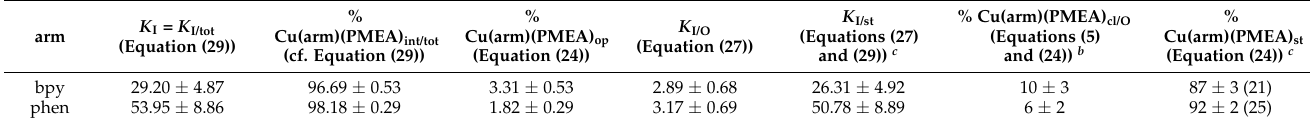
Table 8. Intramolecular equilibrium constants for the formation of the three differently structured Cu(arm)(PMEA) species shown in the Equilibrium Scheme (24), together with the percentages in which these species occur in aqueous solution at 25 ◦ C and I = 0.1 M (NaNO 3 ) a . K I/st % % % Cu(arm)(PMEA) cl/O % K I = K I/tot K I/O arm Cu(arm)(PMEA) int/tot Cu(arm)(PMEA) op (Equations (27) (Equations (5) Cu(arm)(PMEA) st (Equation (29)) (Equation (27)) (cf. Equation (29)) (Equation (24)) and (29)) c and (24)) b (Equation (24)) c bpy 29.20 ± 4.87 96.69 ± 0.53 3.31 ± 0.53 2.89 ± 0.68 26.31 ± 4.92 10 ± 3 87 ± 3 (21) phen 53.95 ± 8.86 98.18 ± 0.29 1.82 ± 0.29 3.17 ± 0.69 50.78 ± 8.89 6 ± 2 92 ± 2 (25) a The values listed in the second column are from the fifth column in the lower part of Table 7. These values for K I = K I/tot follow from Equation (29), and % Cu(arm)(PMEA) int/tot is calculated analogously to Equation (14). The values given in the fourth column for % Cu(arm)(PMEA) op follow from 100 − % Cu(arm)(PMEA) int/tot . The constants K I/O of Column 5 are from the upper part in Column 5 of Table 7 (for the corresponding justification see text in Section 7.2); with Equation (26) and the now known values for K I and K I/tot that for K I/st may be calculated (Column 6). All error limits in this table correspond to three times the standard deviation (3 σ ); they were calculated according to the error propagation after Gauss. b These values were calculated via Equation (26) with K I/O and % Cu(arm)(PMEA) op . c The values for % Cu(arm)(PMEA) st follow from the difference % Cu(arm)(PMEA) int/tot − % Cu(arm)(PMEA) cl/O (cf. Equation (29)); % Cu(arm)(PMEA) st may also be calculated via Equation (27) with K I/st and % Cu(arm)(PMEA) op . The results are the same for both calculation methods (aside from the possible differences in the last digit due to differences in rounding), yet the error limits (which are given in parenthesis) are understandably larger for the second method. This table is reproduced (slight alterations were made) with permission from Table 9 in our publication in Coordination Chemistry Reviews [45]; copyright 1995, Elsevier